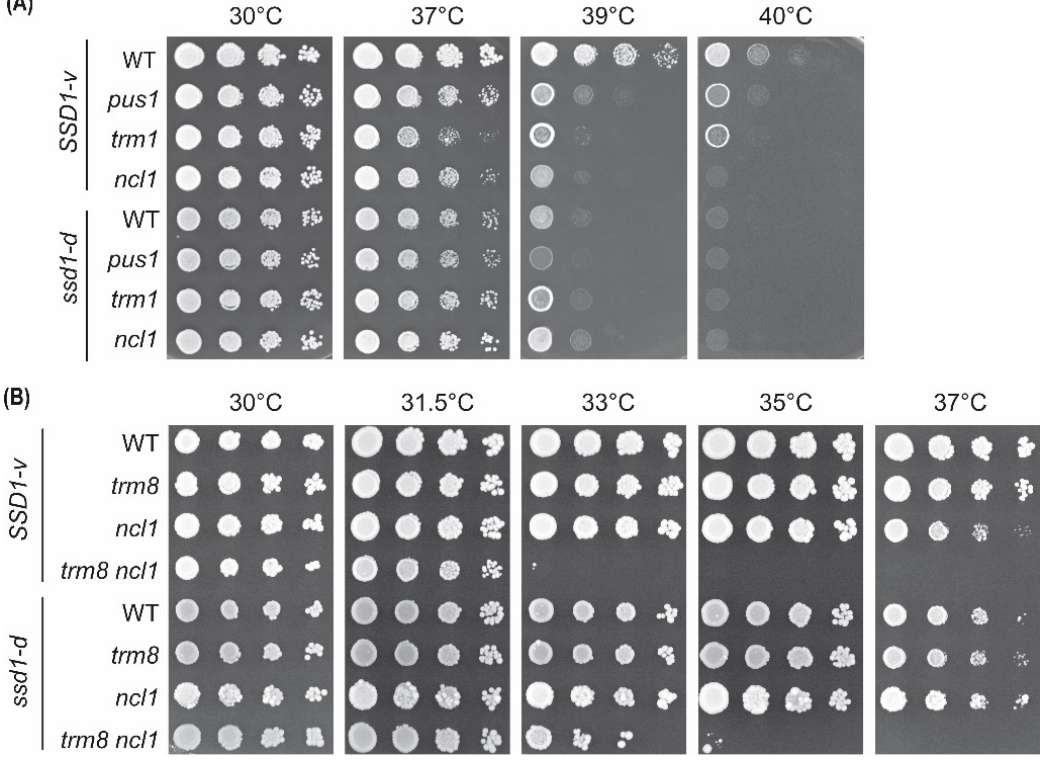
Figure 7. Comparison of the temperature sensitivity of other tRNA modification mutants in SSD1-v and ssd1-d backgrounds. ( A ) Wild-type (WT) and pus1, trm1 , and ncl1 mutants in both SSD1-v and ssd1-d backgrounds were serially diluted, spotted on YPD plates, and incubated at elevated temperatures for 48 h. ( B ) As in ( A ) but using WT and trm8 , ncl1 , and trm8 ncl1 double mutants in both strain backgrounds.